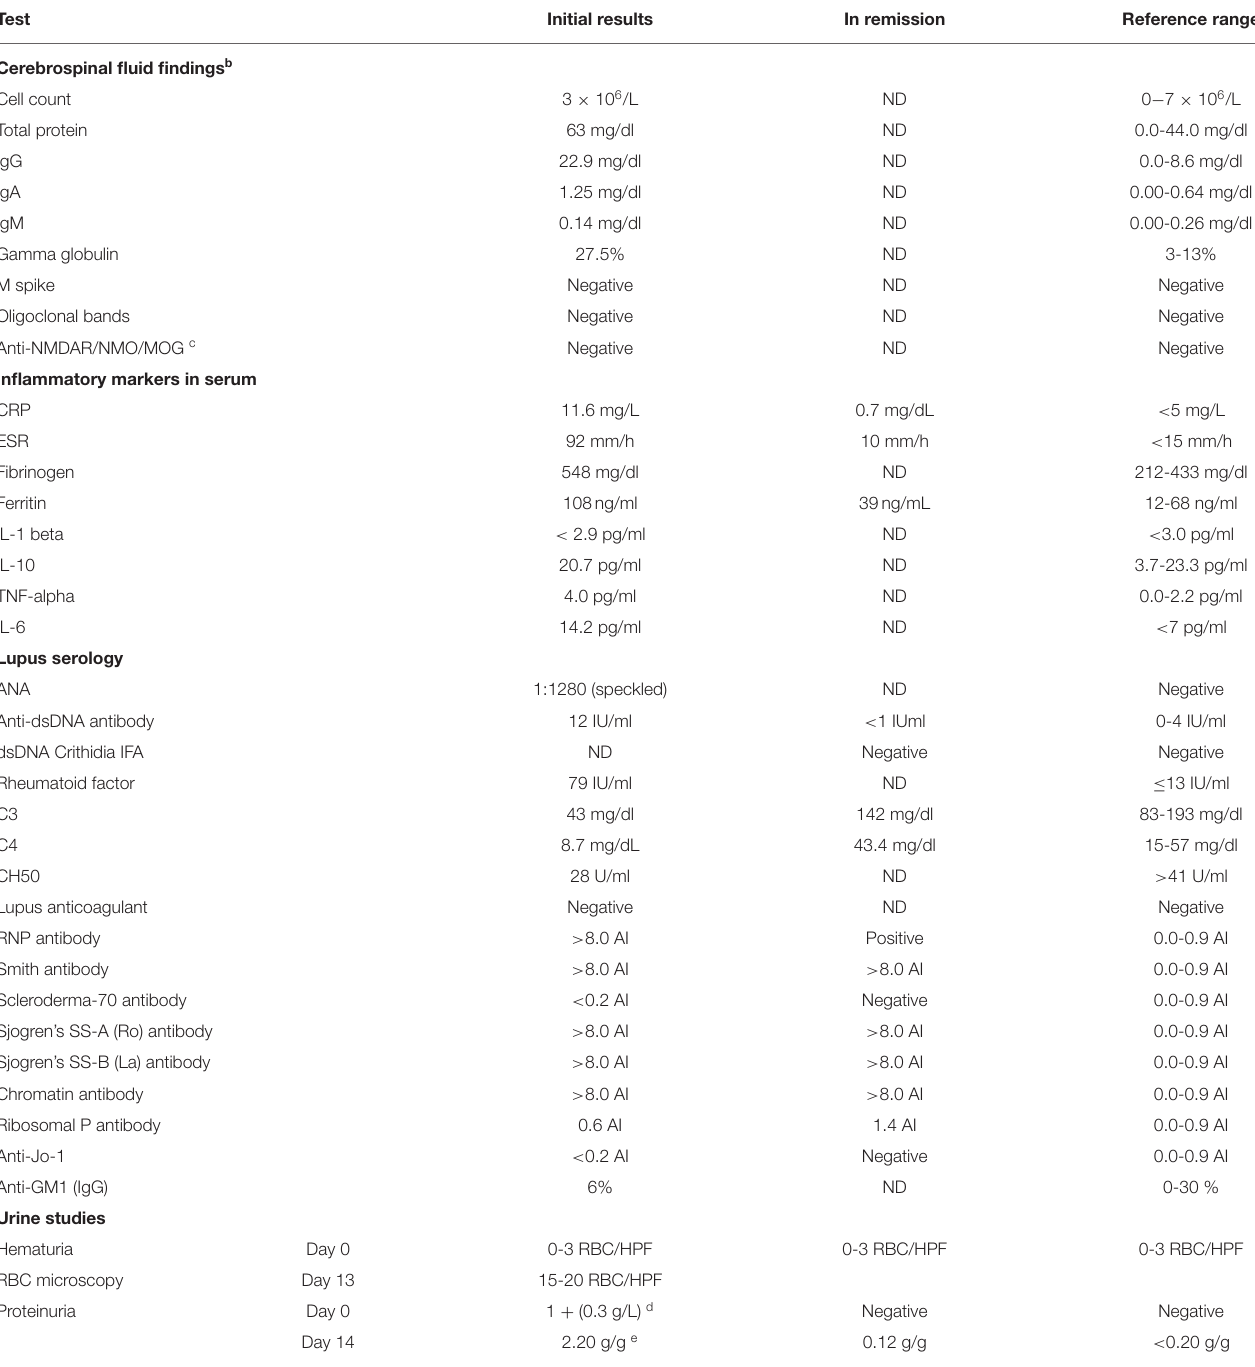
TABLE 1 | Inflammatory markers and lupus serology a .